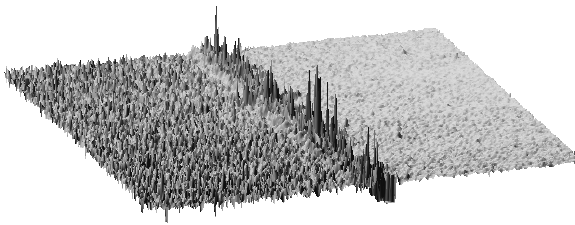
Figure 15. Example of a surface topography.